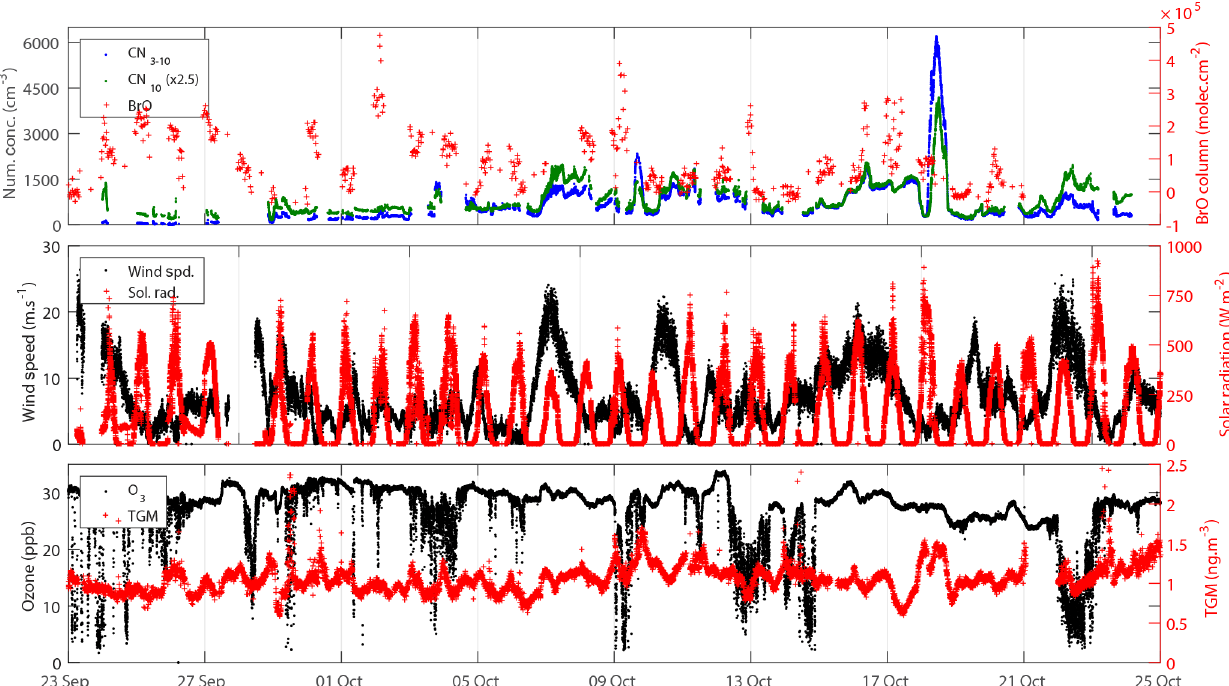
Figure B2. Time series of the full 32 days of measurements of aerosol number concentrations, along with simultaneous measurements of BrO, wind speed, solar radiation, ozone and total gaseous mercury. The 18 October stands out with low BrO and wind speed, high TGM and solar radiation, and no change in